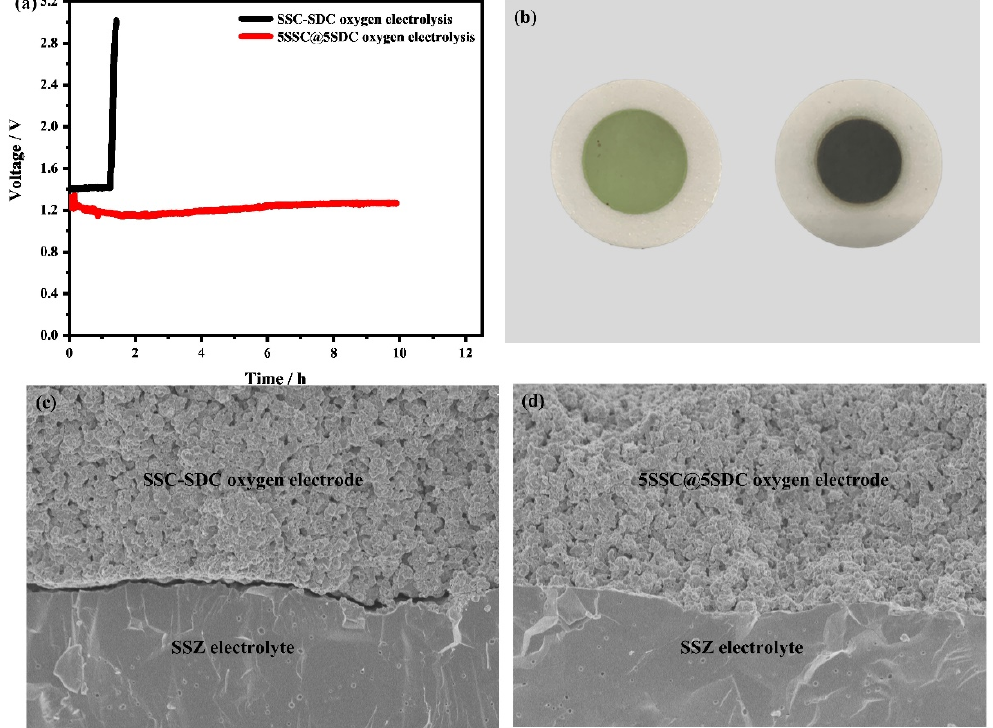
Figure 7. ( a ) Short-term durability testing of RSOC with SSC-SDC and SSC@SDC oxygen electrodes under electrolysis mode at 800 °C (90%H 2 O-10%H 2 humidity condition, the constant current densi- ties of 0.20 A·cm − 2 for SSC-SDC oxygen electrode and 0.40 A·cm − 2 for SSC@SDC oxygen electrode). ( b ) Button cell with electrolyte-support structure employing 5SSC@5SDC oxygen electrode, SSZ electrolyte, and NiO-YSZ anode electrode ( c ) SEM image of interface between electrolyte and oxygen electrode of SSC-SDC after 2 h electrolysis operation, and ( d ) SEM image of 5SSC@5SDC oxygen electrode after 10 h electrolysis operation.